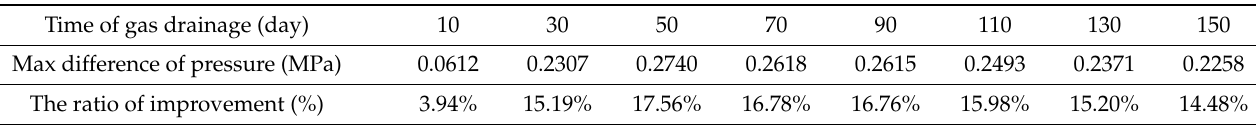
Table 2. Improvement of gas drainage.